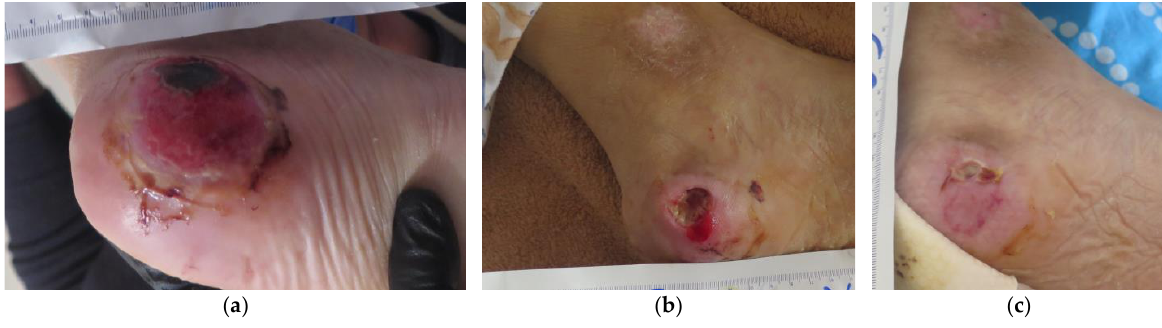
Figure 3. Case 3: ( a ) clinical findings at the initial examination, day 0 (start of MGH treatment); ( b ) progression of wound healing after three weeks of MGH therapy; ( c ) complete wound healing after 8 weeks of MGH therapy.